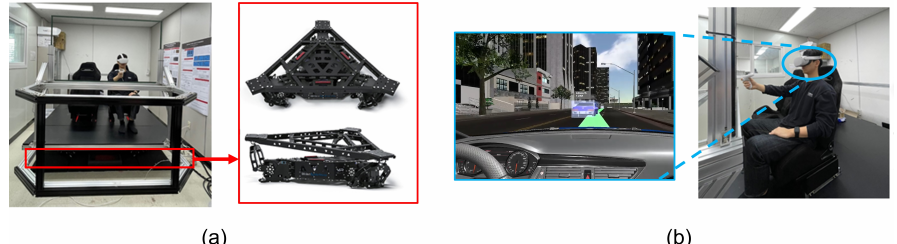
Figure 1. ( a ) Front view of the Motion Platform. An aluminum profile-based mock-up was built to give realistic riding experience to the users. PS-3TM-LP550 motion was used to provide realistic motions of the virtual self-driving vehicle in the VR simulation. ( b ) Subject on Motion Platform wearing Oculus Quest 2 VR HMD, controlling the self-annotation panel with the joystick. The HMD offers a realistic view of the graphical simulations to the users.